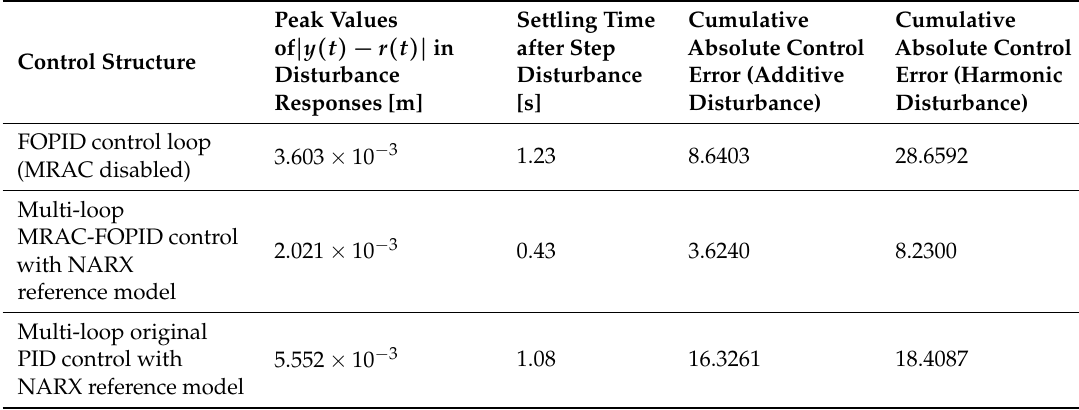
Figure 16. Sine wave disturbance responses of MRAC system with original PID control loop. Table 4. Comparison of experimental performances of control systems with the MRAC loop disabled and